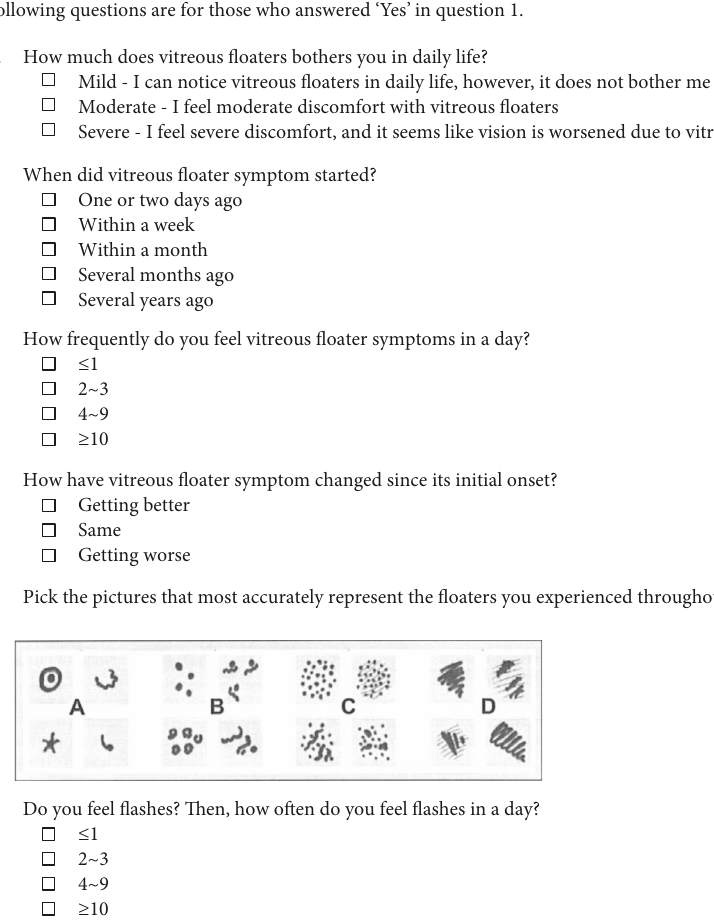
Figure 1: Vitreous Floaters Symptom Questionnaire. This is the vitreous fl oaters questionnaire used in this study, which was translated from Korean to English. The drawing in question 6 was adopted from van Overdam et al.